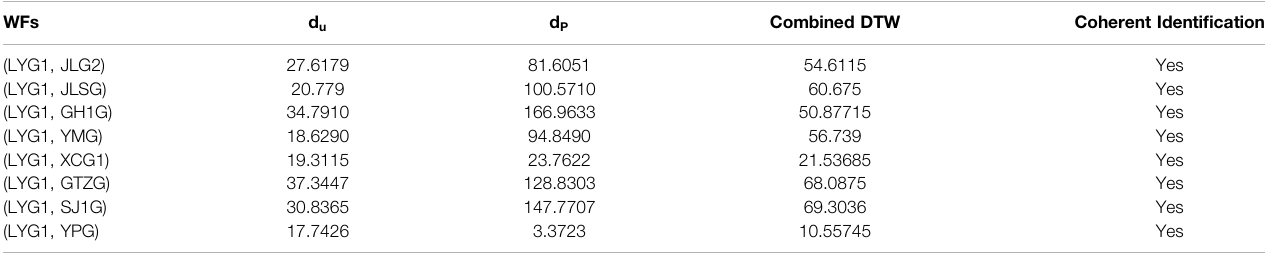
TABLE 4 | Results of combined DTW distance in Group 6.